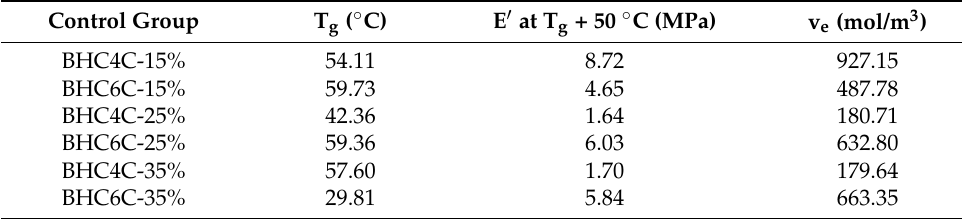
Table 4. Viscoelastic properties of MF coating films for the control group.